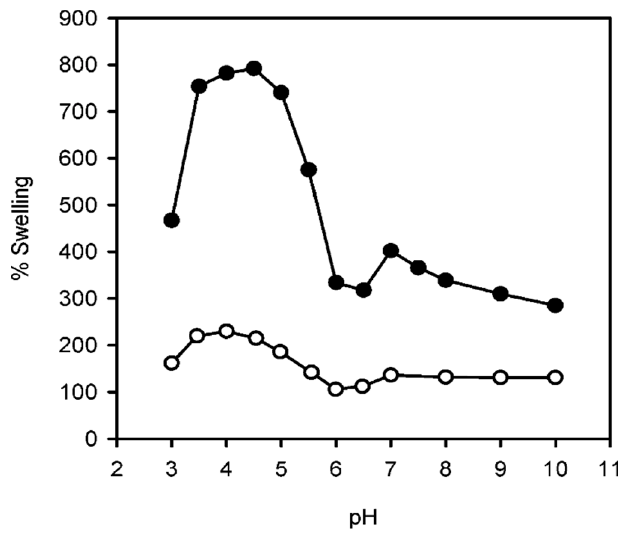
Figure 10. Dependence of the degree of swelling for (PLL / HA) 75 films assembled at pH 5 ( ◦ ) and 9 ( • ). Figure taken from reference [145], Copyright © 2020 American Chemical Society.